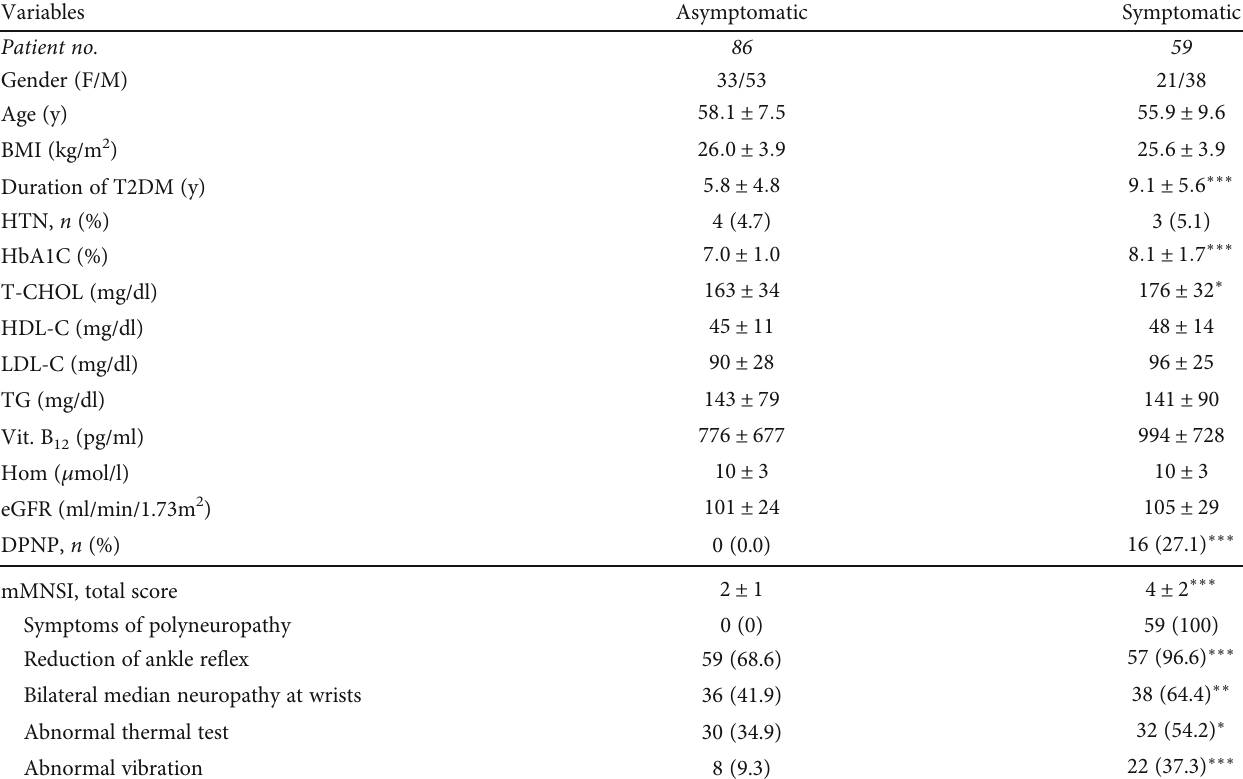
Table 5: Demographic characteristics, neurologic examinations, and electrophysiologic studies for the symptomatic and asymptomatic a